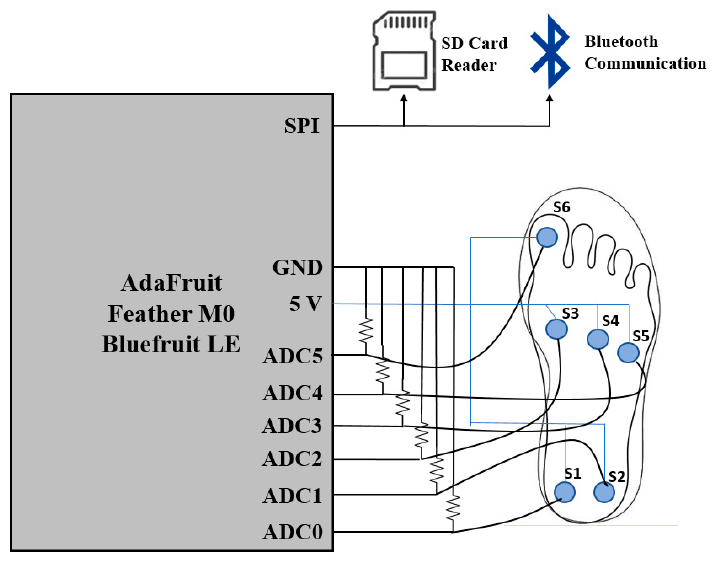
Figure 1. Schematic of the developed pressure sensor